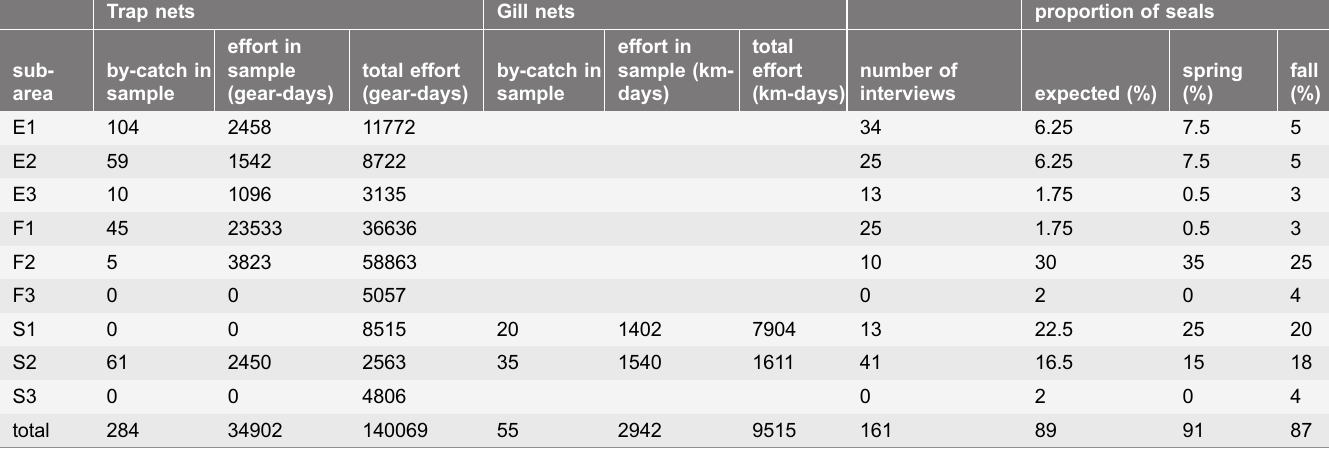
Empty gill net cells represent areas where we assume gill nets do not contribute to